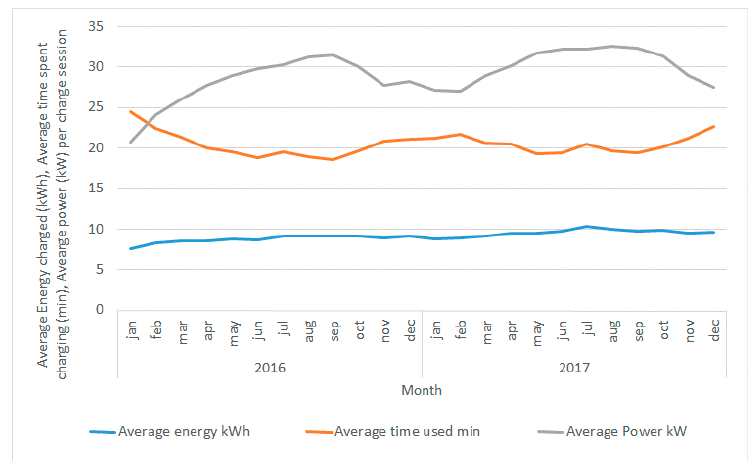
Figure 12. Variation over the year of the average energy charged, the average time used for charging and the average achieved charge power during the charge session. January 2016 to December 2017. Source: Dataset 1 and own analysis.